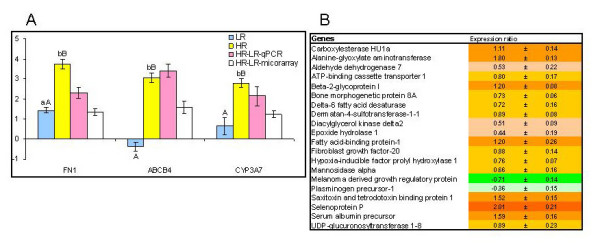
Genes involved in tissue protection, clearance and reparation. A. Real-time qPCR versus microarray analyses. Data for qPCR are ΔΔCt ± SE of 10 HR and 10 LR versus 8 fish in the unchallenged control and data for microarray are mean log-ER ± SE of 6 HR fish hybridized to a pooled sample of 10 LR fish. Differences between HR and LR determined with microarrays and qPCR are shown. Different capital letters (A, B) denote a difference between challenged fish (HR and LR) while small letters (a, b) denote a difference between challenged and control fish (ANOVA, P < 0.05). FN1 - fibronectin, ABCB4 - liver bile salt export pump. B. Microarray results, examples of differentially expressed genes with significant differences between vaccinated and unvaccinated fish (t-test, n = 6 and 5, p < 0.05). Results for unvaccinated fish are not shown, data are log2-ER ± SE.